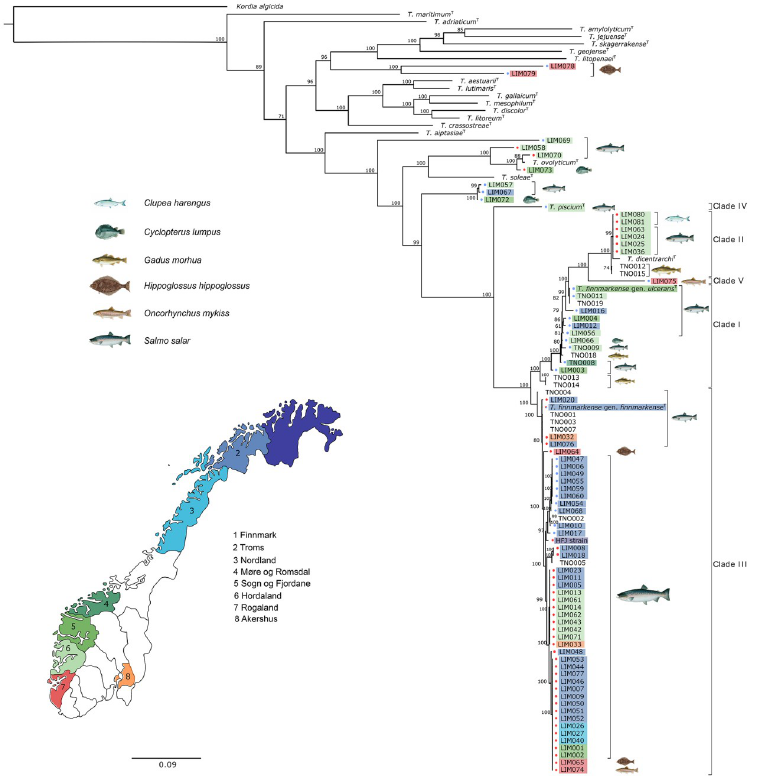
Fig 2. Bayesian analysis. Bayesian phylogenetic tree of 103 Tenacibaculum strains based on concatenated sequences of seven genes ( atpA , dnaK , glyA , gyrB , infB , rlmN and tgt , total size: 3894 bp). The data set includes 66 Tenacibaculum strains isolated during this study (LIM strains), the HFJ strain previously isolated and 36 strains from GenBank (15 from [28] (TNO strains) and 21 Tenacibaculum Type Strains). Kordia algicida was used as an outgroup. Posterior probabilities are indicated at each node. Fish symbols indicate the host from which each strain has been isolated (LIM and TNO) and colours indicate the Norwegian administrative regions, accordingly to the map. Colour dots indicate if the strains show haemolytic activity on blood agar (red dot), not (blue dot) or variable (red/blue dot). Clades I-V represent the structure of the T . finnmarkense / T . dicentrarchi group of isolates. The Norwegian map was reprinted from https://doi.org/10.1371/journal.pone.0215478 under a CC BY license, with permission from Are Nylund, original copyright 2019. This map is similar but not identical to the original image and is therefore for illustrative purposes